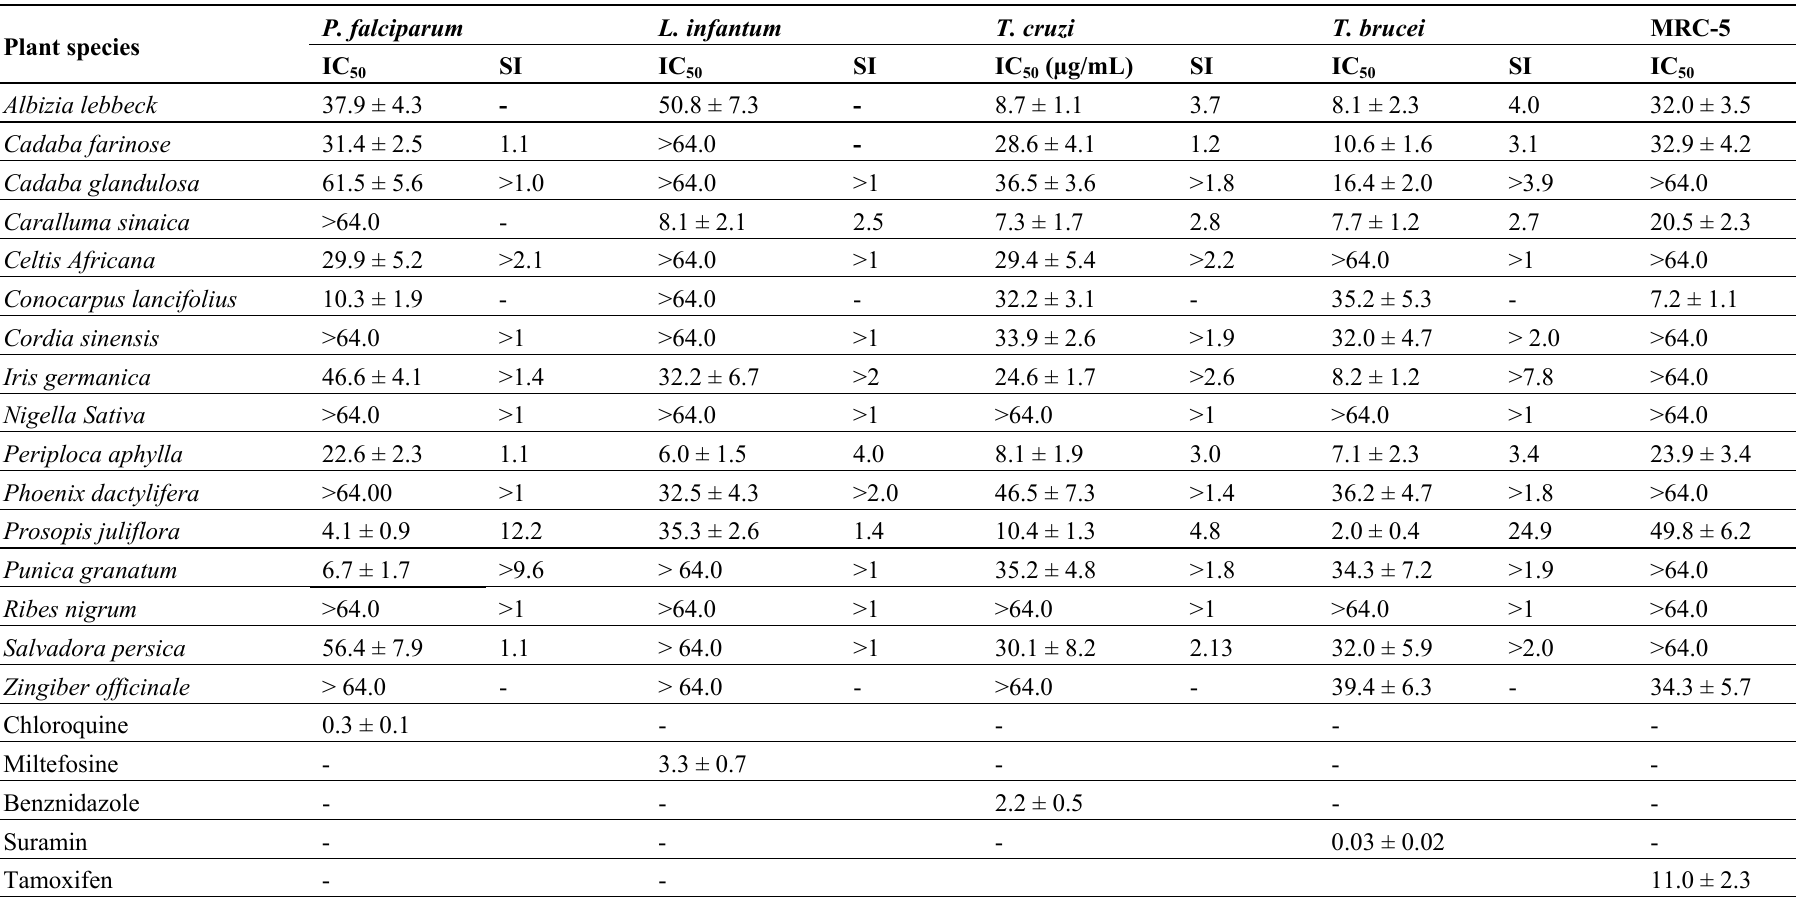
Table 2. Antiprotozoal activity of the extracts of the investigated plants and their cytotoxicity against MRC-5 cell lines. Plant